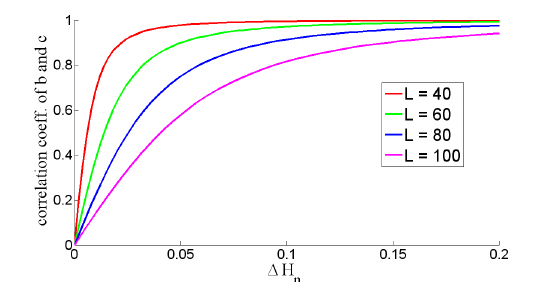
Figure 10. Correlation coefficient of b and c vs. Δ H